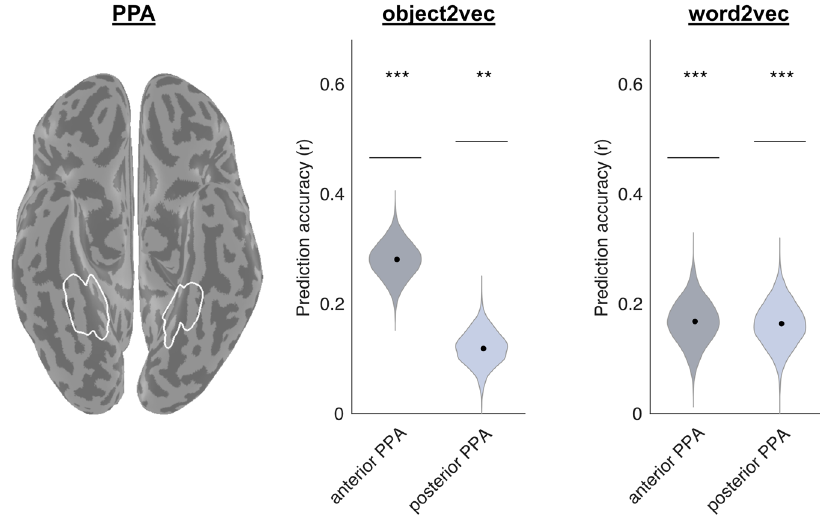
Fig. 4 Encoding models of visual and linguistic context predict fMRI responses to objects in PPA. This plot shows the average prediction accuracies for encoding models in voxels from the anterior third and posterior third of the PPA using either image-based object2vec representations as regressors or language-based word2vec representations. The violin plots show the mean prediction accuracies (central black dots) and bootstrap standard deviations. The gray lines above each violin plot indicate the average voxel-wise split-half reliability of the fMRI responses in each ROI. Prediction accuracies for both models were above chance, but the highest accuracy was observed for object2vec in the anterior PPA. The image on the left shows the PPA parcel on a ventral view of a cortical surface rendering. PPA parahippocampal place area. ** p < 0.01, *** p < 0.001, uncorrected, one-sided permutation test. Exact p -values for object2vec: anterior PPA p -value = 2.0e − 04; posterior PPA p -value = 2.4e − 03. Exact p -values for word2vec: anterior PPA p -value = 4.0e − 04; posterior PPA p-value = 2.0e − 04. Source data are provided as a Source Data fi le.